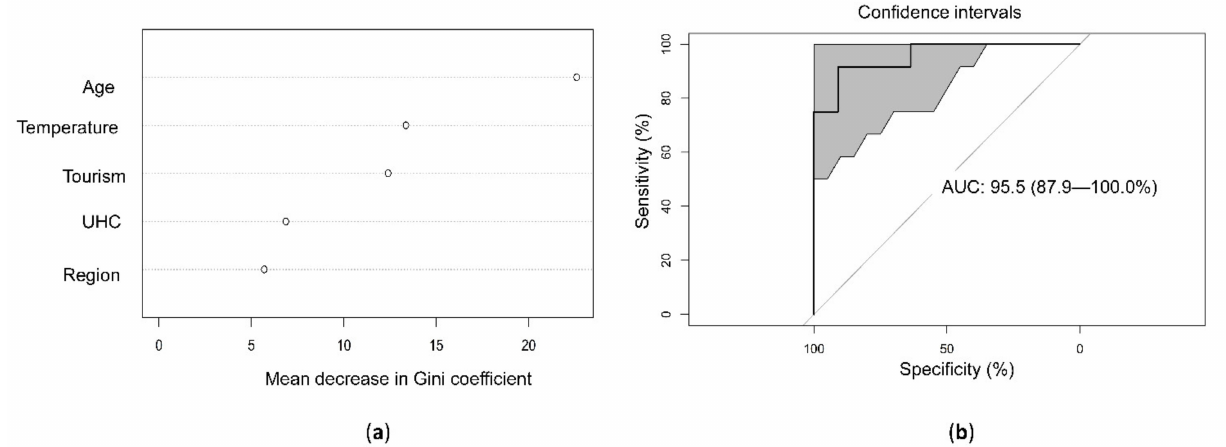
Figure 5. ( a ) Important variables for the incidence risk of severe acute respiratory syndrome coronavirus 2 modeled by random forest; ( b ) the accuracy of the prediction model, which is validated in the test set. The 95% confidence interval of receiver operating characteristic using bootstrap resampling for 2000 replicates was